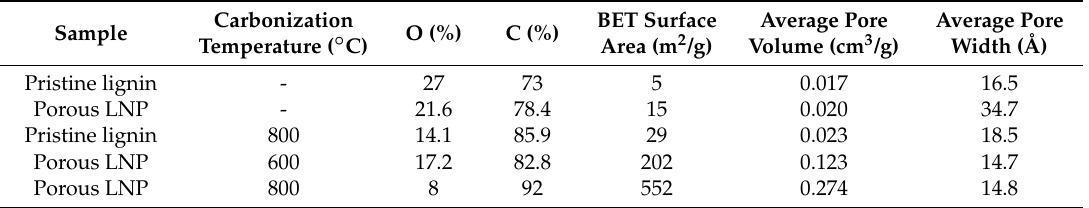
Table 4. Oxygen and carbon composition determined by X-ray photoelectron spectroscopy (XPS) and structure parameters obtained by the Brunauer–Emmett–Teller (BET) method for samples before and after carbonization at different temperatures. Adapted with permission from [103]. Copyright 2017 American Chemical